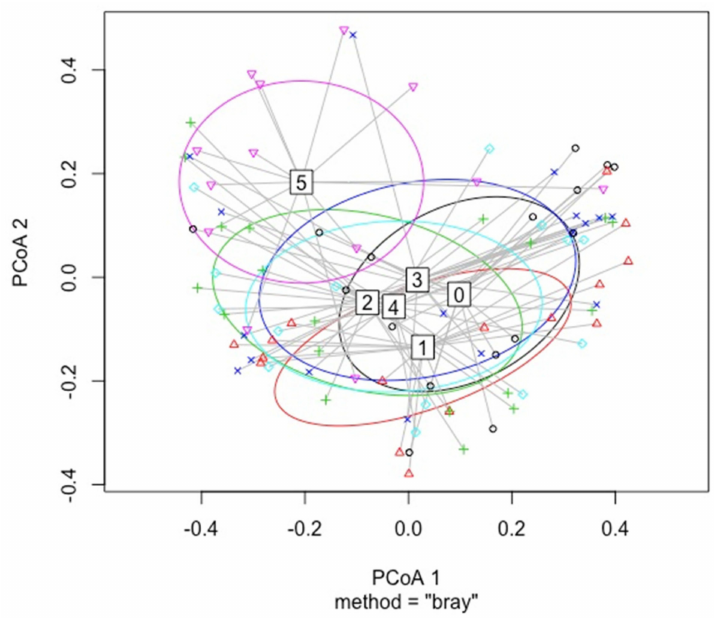
Figure 6. Dispersion of the indicator species of the diseased trees (disease class 5) (67 OTUs) (permu- tation test using the Bray method) between different disease classes